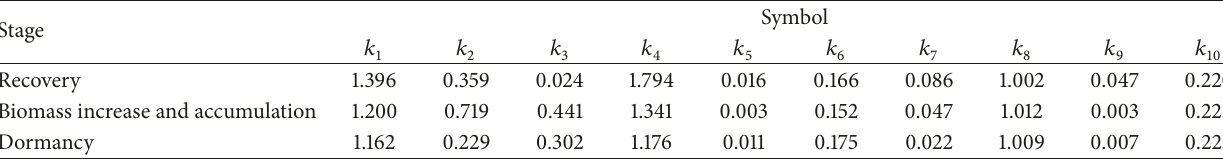
Table 1: Average values of unknown model parameters of each